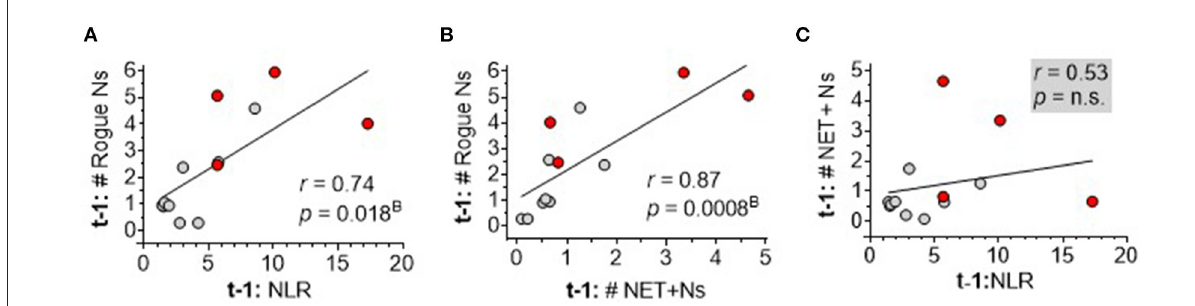
FIGURE6 Spearman rank correlation analysis of three neutrophil-based markers among each other. (A) Correlation of same day (t-1) DEspR + CD11b + neutrophil counts, (Rogue Ns, K/ µ l), (t-1: # Rogue Ns) with neutrophil-lymphocyte ratio (NLR); (B) correlation of t-1:# Rogue Ns with NET-forming neutrophil counts (NET + Ns, K/ µ l), (t1: # NET + Ns); and (C) correlation of t-1: # NET + Ns with NLR. Ns, neutrophils; t1: day of flow cytometry; red • symbols represent sICH nonsurvivors; gray • symbols mark values for sICH survivors; r , Spearman rank correlation coefficient; p B , p -value with Bonferroni correction. n.s. not significant.